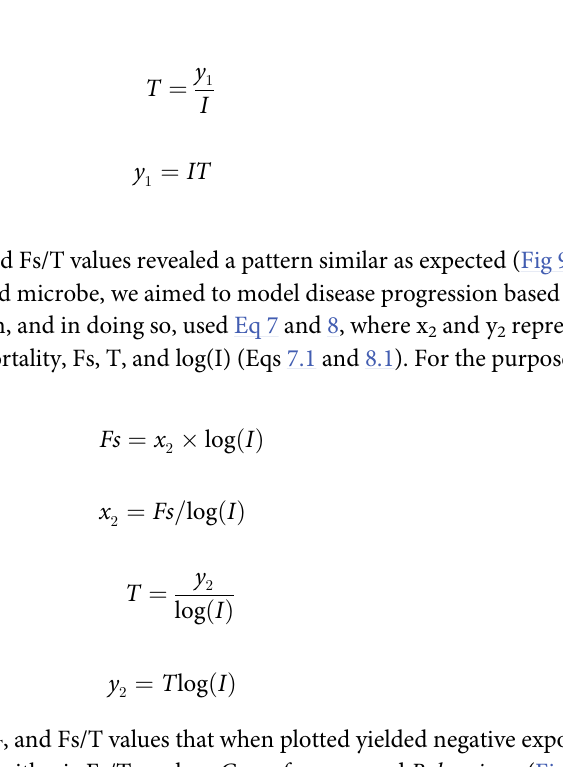
This resulted in PP, PP , and Fs/T values that when plotted yielded negative exponential PP T and a positive logarithmic Fs/T, such as C . neoformans and B . bassiana (Fig 9, pink and PP T data points).